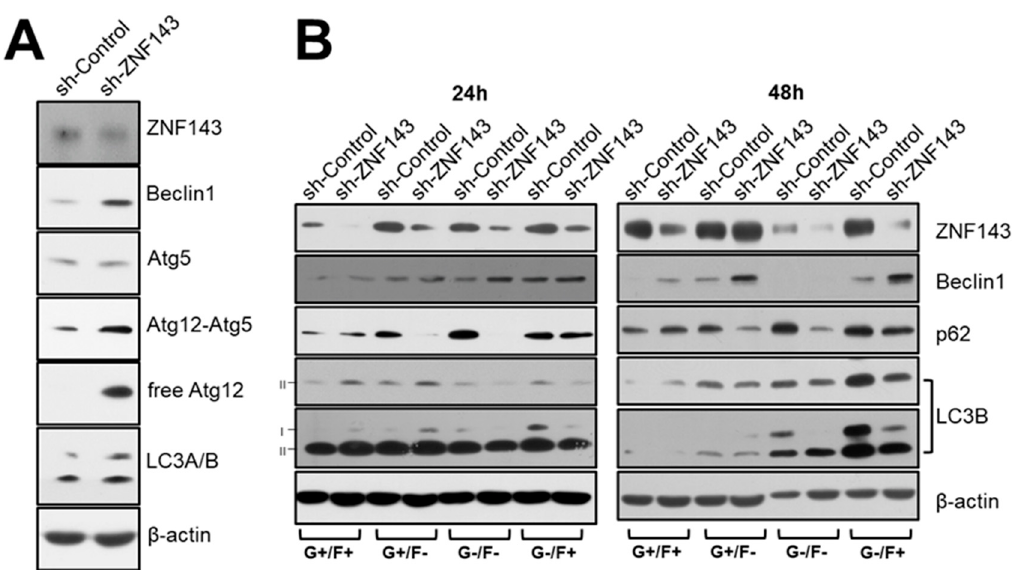
Figure 3. Proteins related to autophagic processes are altered in MCF7 sh-ZNF143 cells. ( A ) Growing cells were harvested for immunoblotting for autophagic-related proteins. ( B ) Growing cells were exposed to four different media (G+/F+, G+/F − , G − /F − , G − /F+; G: glucose, F: FBS, respectively) for additional time periods, as indicated, then harvested for immunoblotting. Results shown are representative of at least three independent experiments.